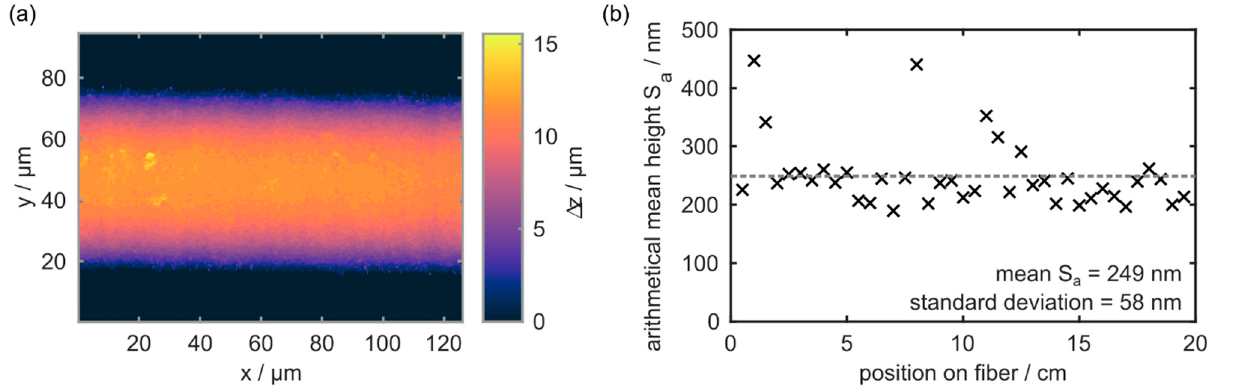
Figure 9. ( a ) Exemplary surface profile acquired via white-light interferometry. ( b ) Arithmetical mean height, or S a value, of a micromachined sapphire fiber with an average diameter of 90 μ m over a length of 20 cm.